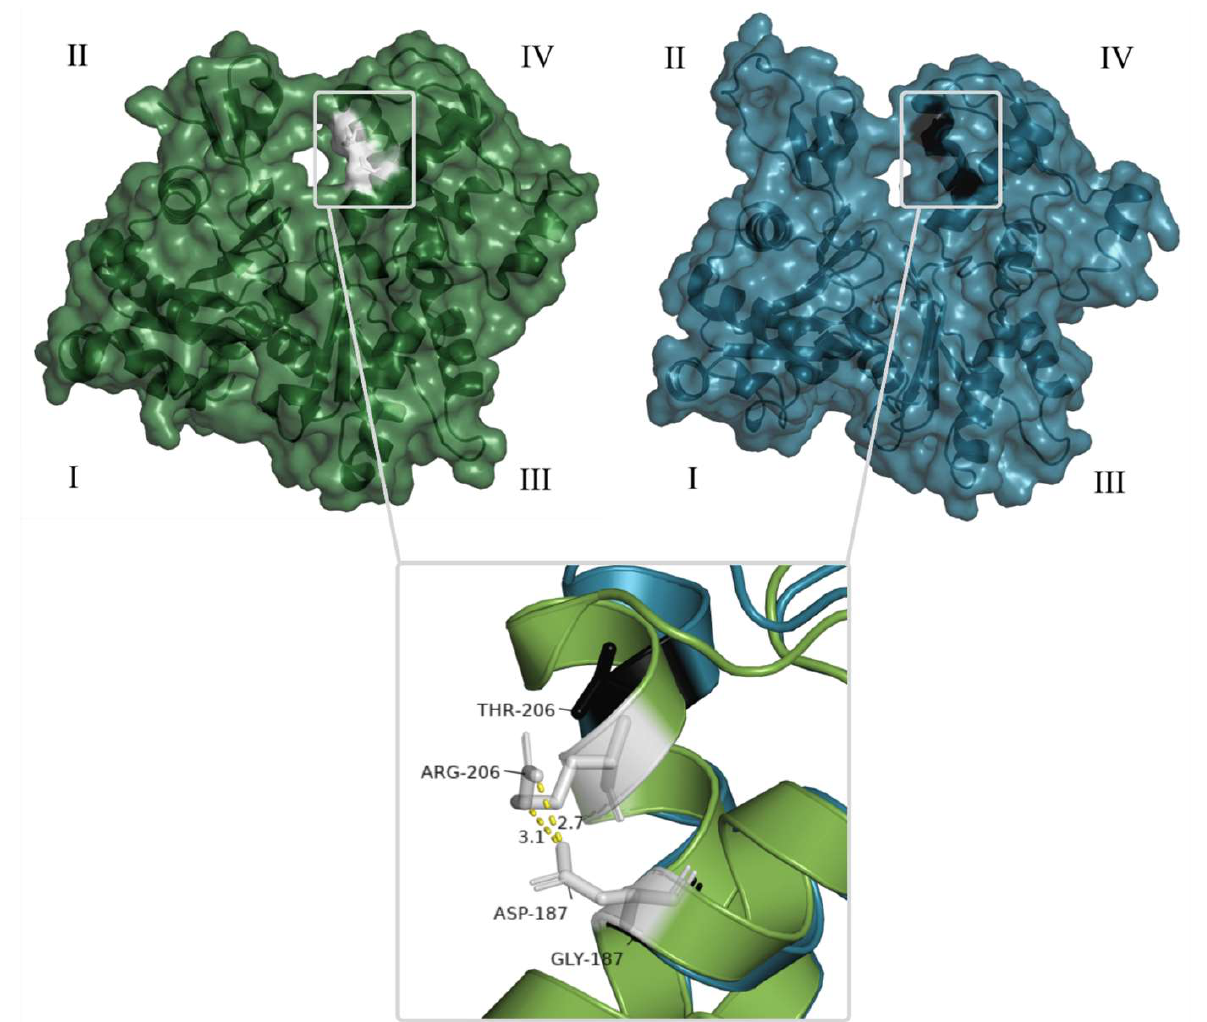
Figure 8. Overall comparison (upper left and right) and close-up comparison (lower middle) of a model of native G-actin (green, upper left, PDB: 3HBT, 375 aa) and an in silico hybrid-model of a combination of the amplified and sequenced Chromodoris actin (286 aa) and subsequently added parts of an Armina tigrina actin sequence (89 aa), to approximate missing amino acids (blue, upper right, 375 aa). Native aspartic acid D187 (ASP, acidic) and arginine R206 (ARG, basic), shown in white, form a salt bridge (yellow lines, 3.1 and 2.7 Å), whereas the substitutions glycine G187 (GLY, nonpolar) and threonine T206 (THR, neutral), shown in black, present in Chromodoris actin, do not interact. Both substitutions are adjacent to the nucleotide binding cleft and are part of the latrunculin-binding region.